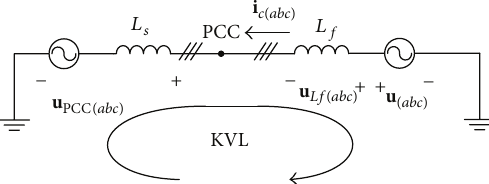
Figure 10: The equivalent circuit of the SAPF connected with the voltages at the PCC